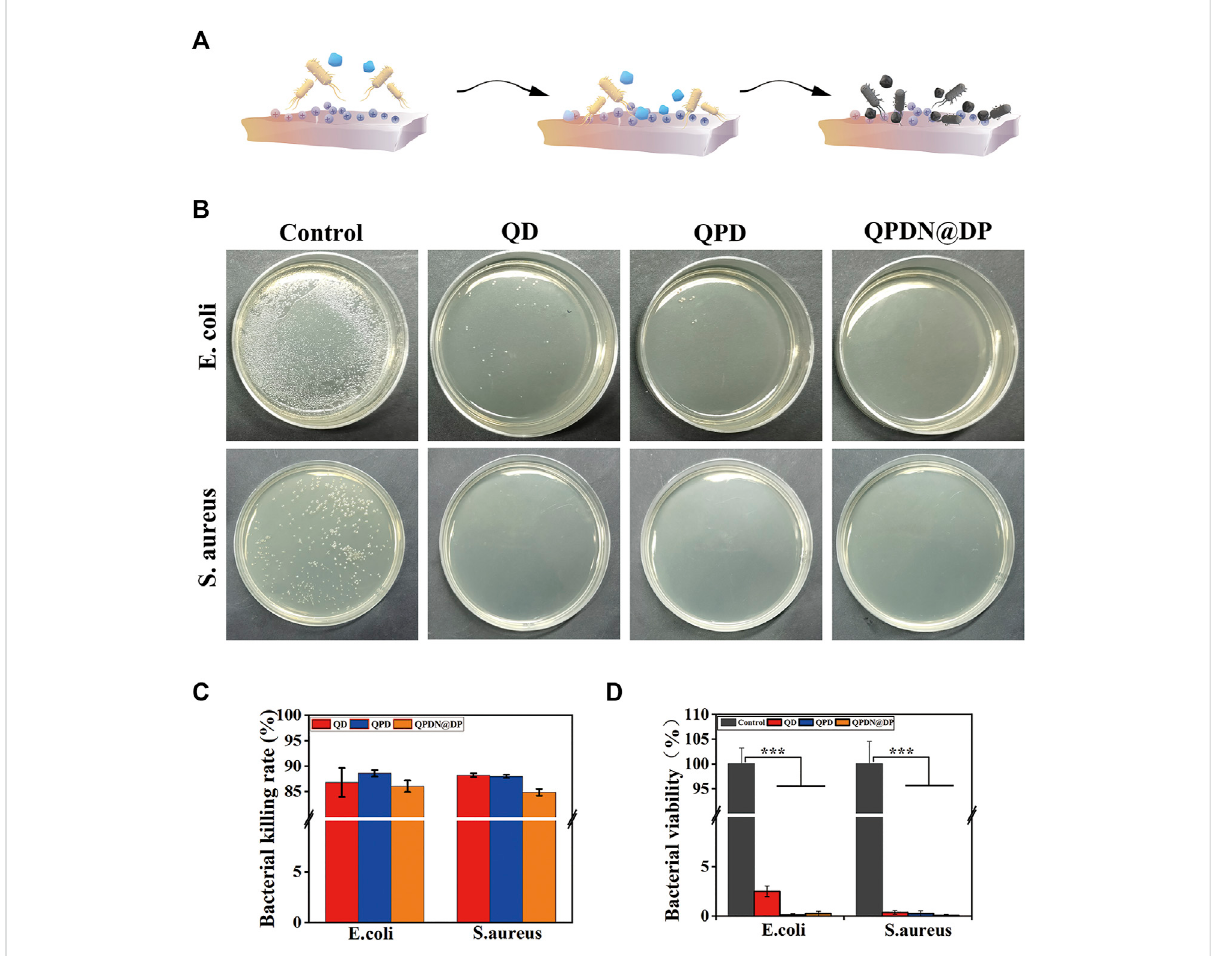
FIGURE 4 Antibacterial activity of the hydrogels. (A) Schematic diagram of the principle of contact antibacterial. (B) Antibacterial performance of the presentedtreatmentsagainstS.aureusandE.coliasdeterminedbyCFUcounts. (C) Hydrogelssterilizationrate. (D) Bacterialviability.Mean±SD( n = 3). * p < 0.05, ** p < 0.01, *** p <